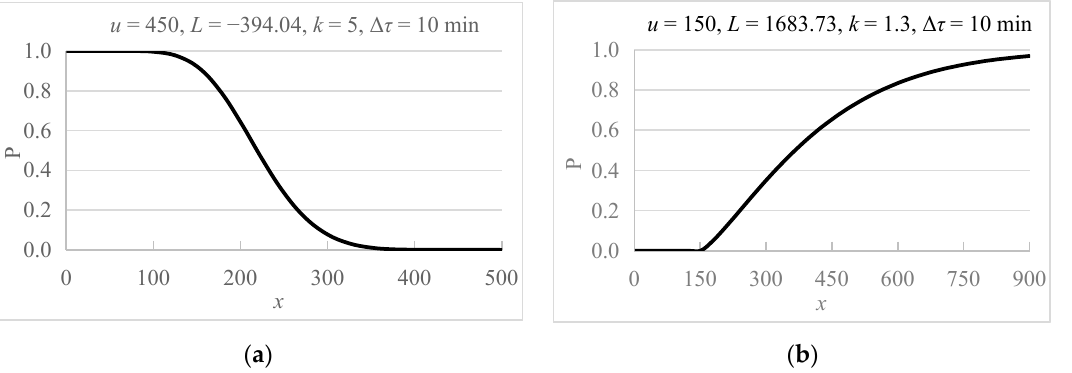
Figure 4. The probability of turning on/off the lights. ( a ) Probability of turning on the lights; ( b ) Probability of turning off the lights.